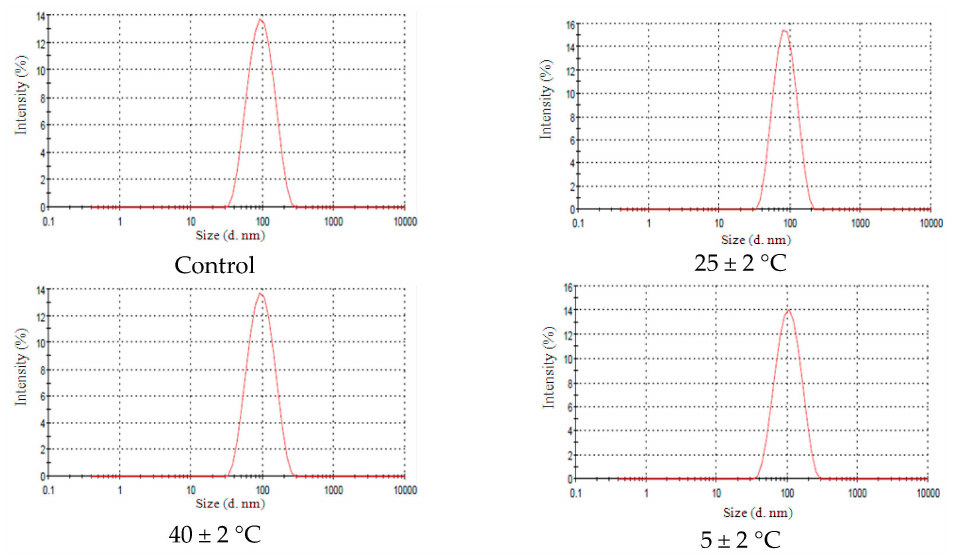
Figure 8. Narrow droplet size NE-AL 2% distribution under different conditions after 90 days of storage.